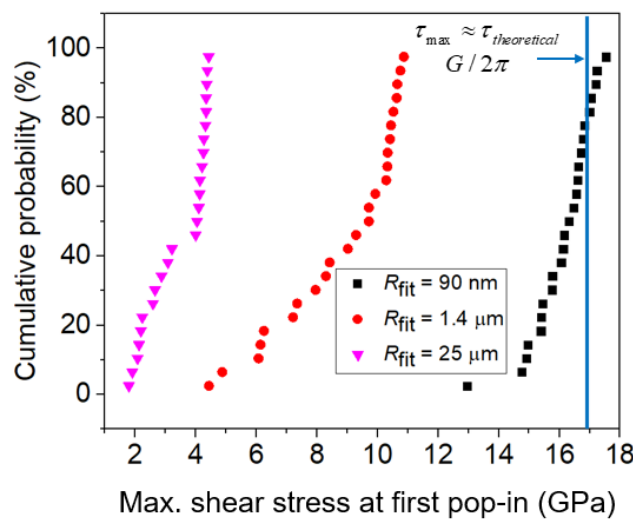
Figure 5. Indentation pop-in statistics on single crystal (001)-SrTiO 3 with tip radii of 25 μm, 1.4 μm and 90 nm. The data on 25 μm and 90 nm were adopted from [27].